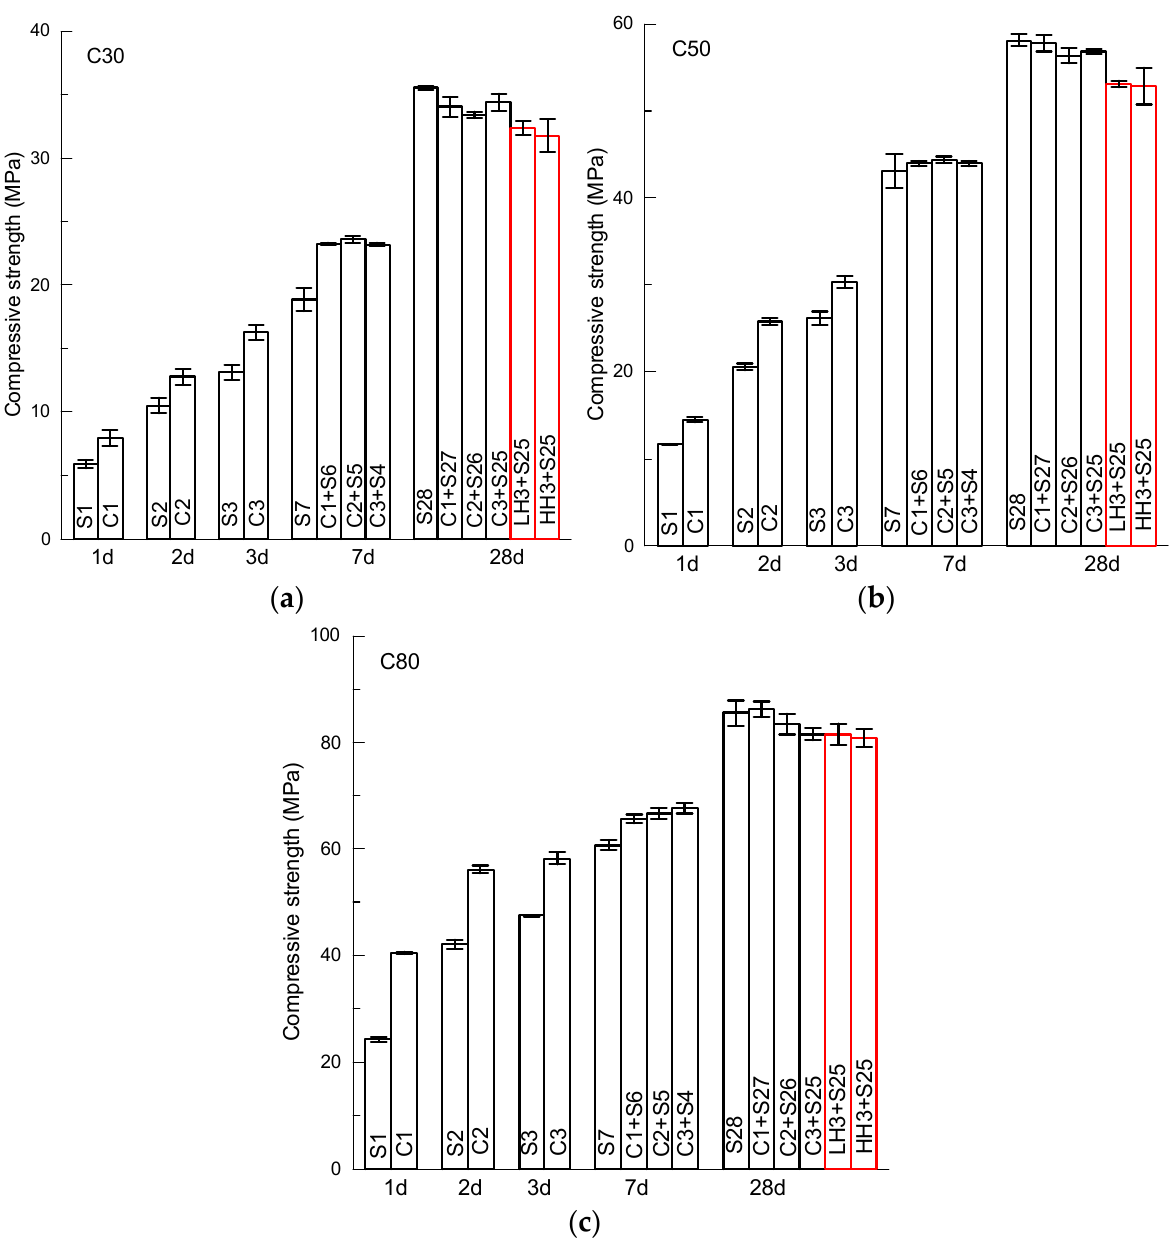
Figure 3. Compressive strength of concrete under different curing procedures ( a ) C30, ( b ) C50 and ( c ) C80.